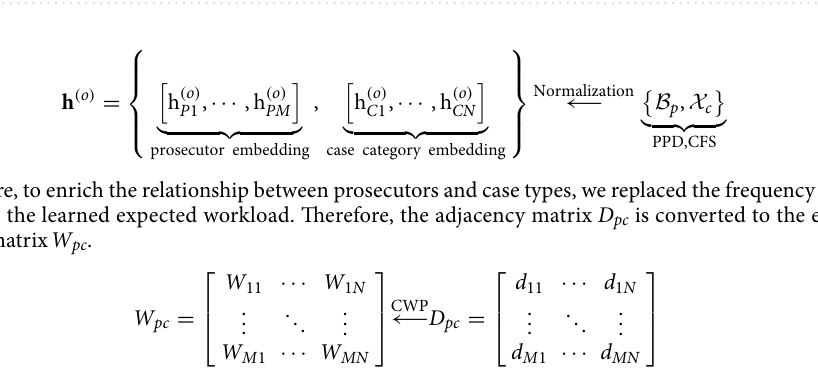
Figure 3. Graph Neural Network Recommendation